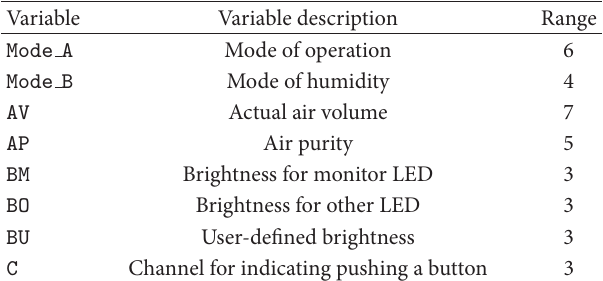
Table 1: Variables in the example specification for function 𝐹 𝑙